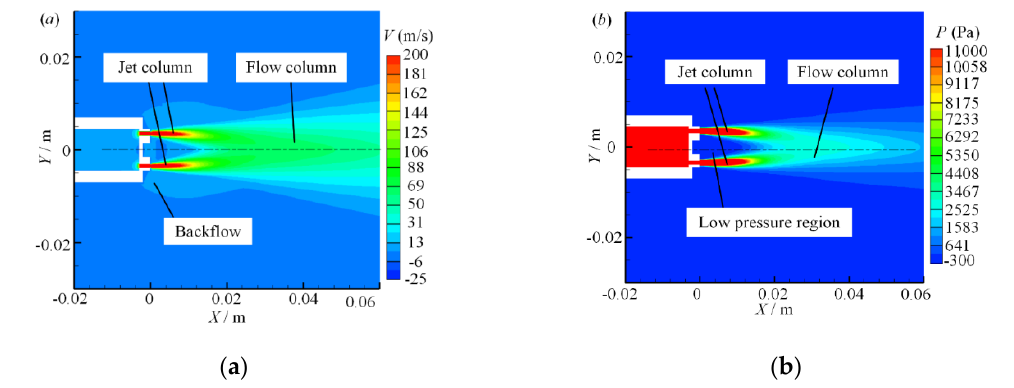
Figure 6. Symmetry plane 2 contours of the first confluence: ( a ) velocity contour; ( b ) pressure contour.